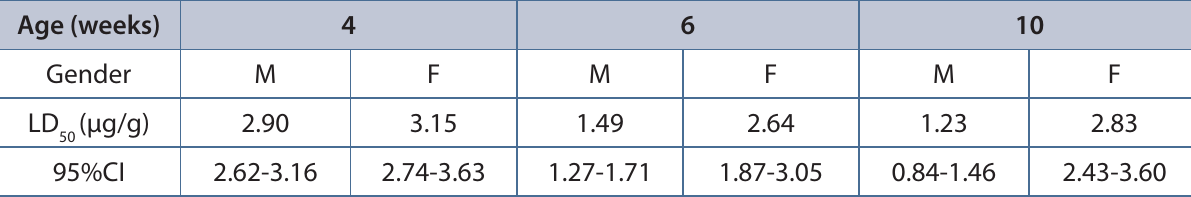
Table 1. Median lethal dose of Tityus serrulatus venom by age and sex Age (weeks) Gender LD (µg/g) 50